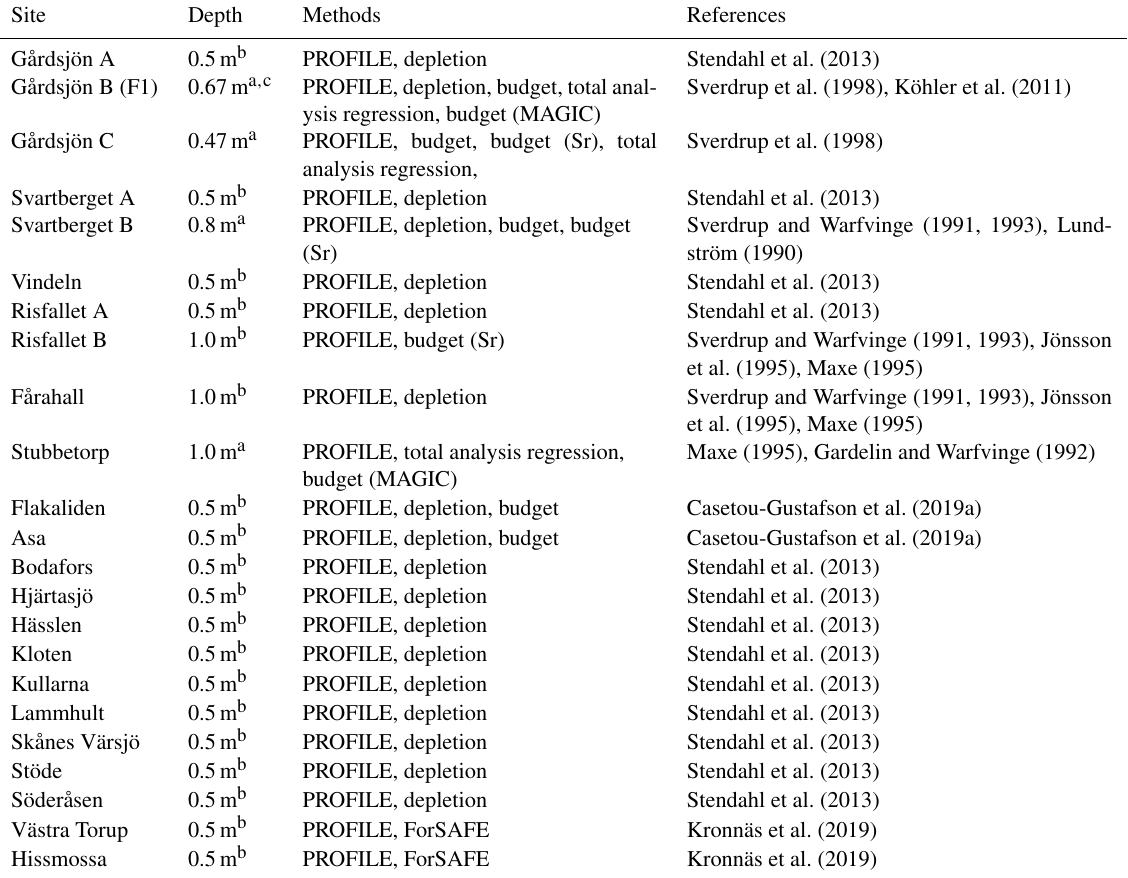
Table 1. Sites included in the study, where at least two well-documented approaches for estimating weathering rates have been applied to the same